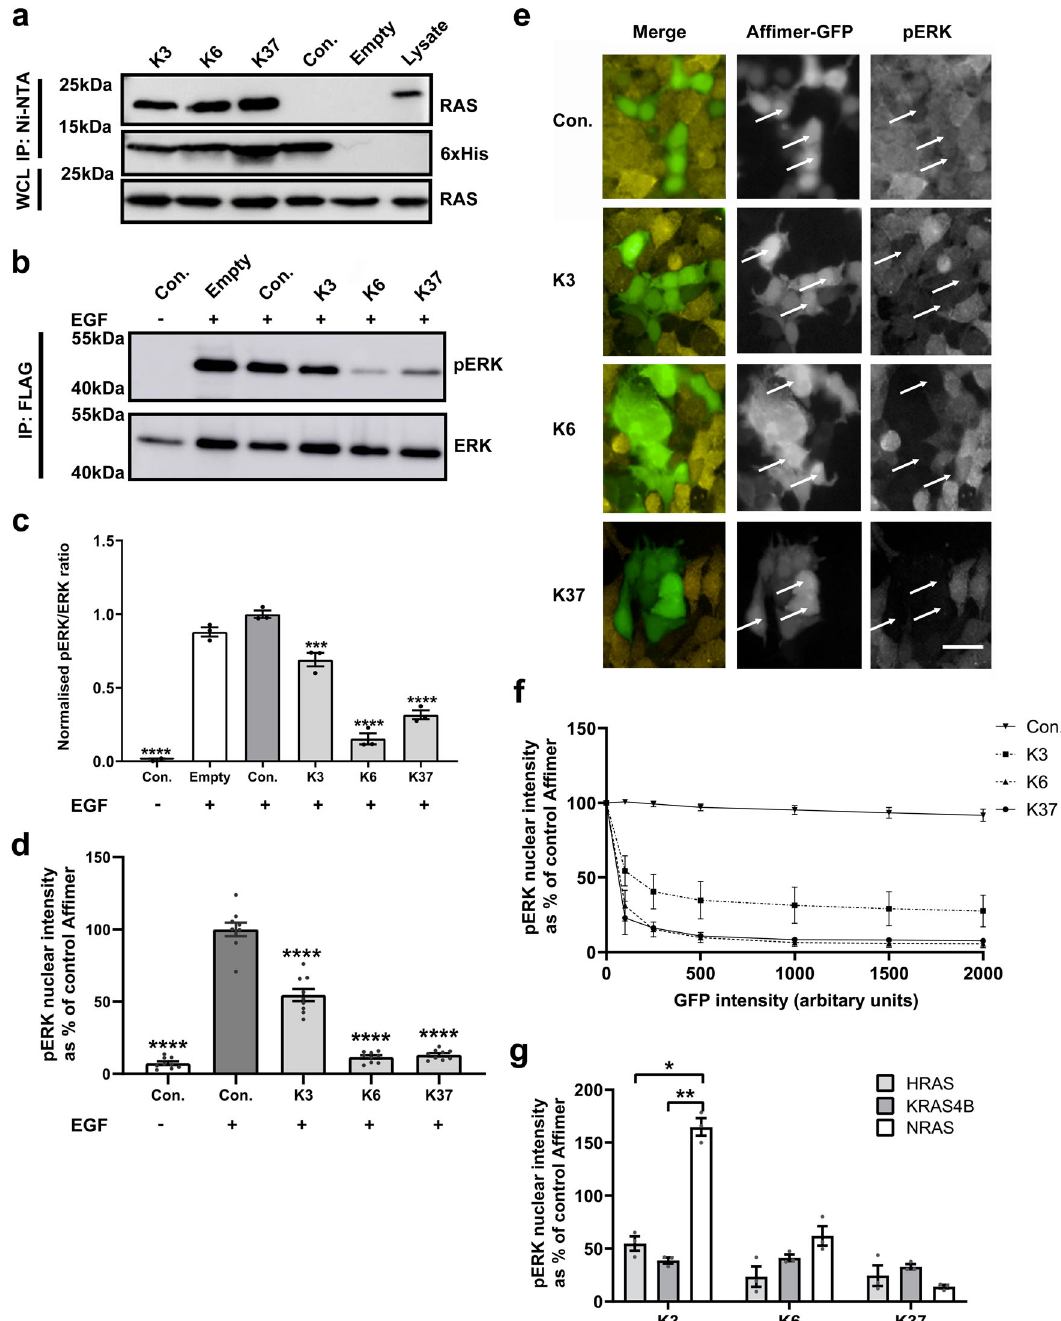
robust inhibition of ERK phosphorylation in KRAS-expressing MEFs with K6 and K37 showing a similar level of inhibition in MEFs expressing HRAS and NRAS. By contrast, K3 showed variant speci fi city, with inhibition of NRAS signi fi cantly ablated whilst the degree of inhibition for HRAS was reduced, but not signi fi cantly when compared with that of KRAS (Two-way ANOVA with Tukey ’ s post hoc test p = 0.0237 for NRAS vs. HRAS and p = 0.0096 for NRAS vs. KRAS) (Fig. 2g). Thus, the cellular data support the biochemical data that Af fi mer K3 has a preference for KRAS over NRAS, with HRAS values being intermediate. To evaluate the impact of the Af fi mer proteins on MAPK signaling in the presence of mutant, oncogenic forms of KRAS, the following cancer cell lines were utilized: Panc 10.05